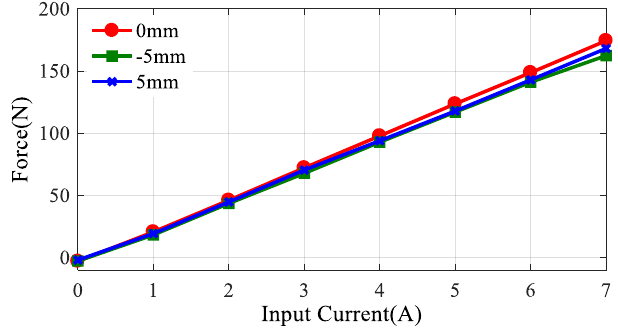
Figure 7. Force with different current input.